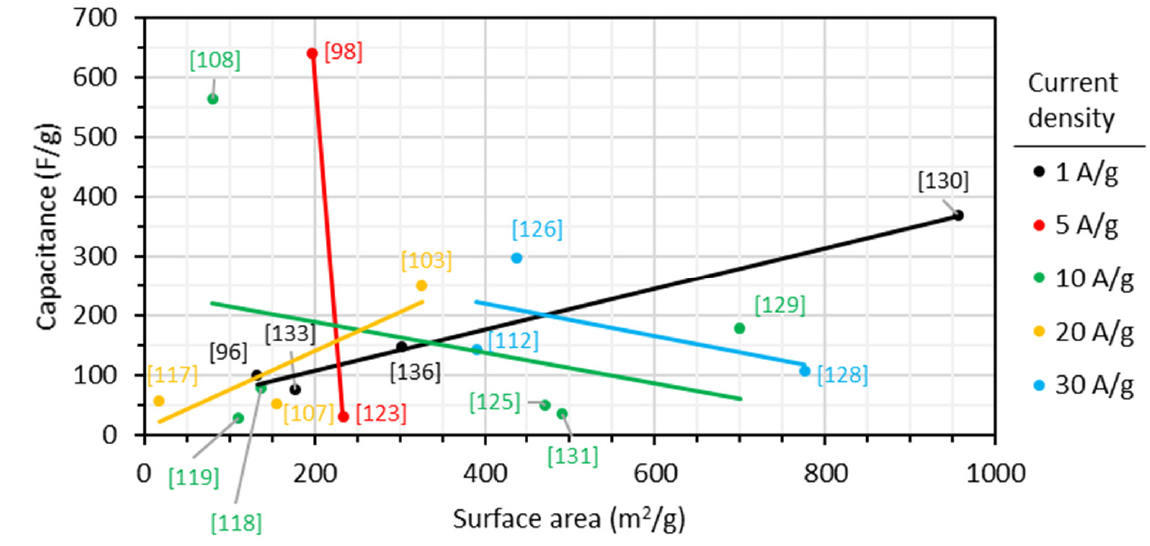
Figure 8. Relation between capacitance and surface area values of M-BCH included in this review. Only data from Table 6 expressed in F/g and m 2 /g—for capacitances and surface areas, respectively—are included. Straight lines represent linear-fitted trends for each set of data. Numbers between brackets correspond to the references [own elaboration].